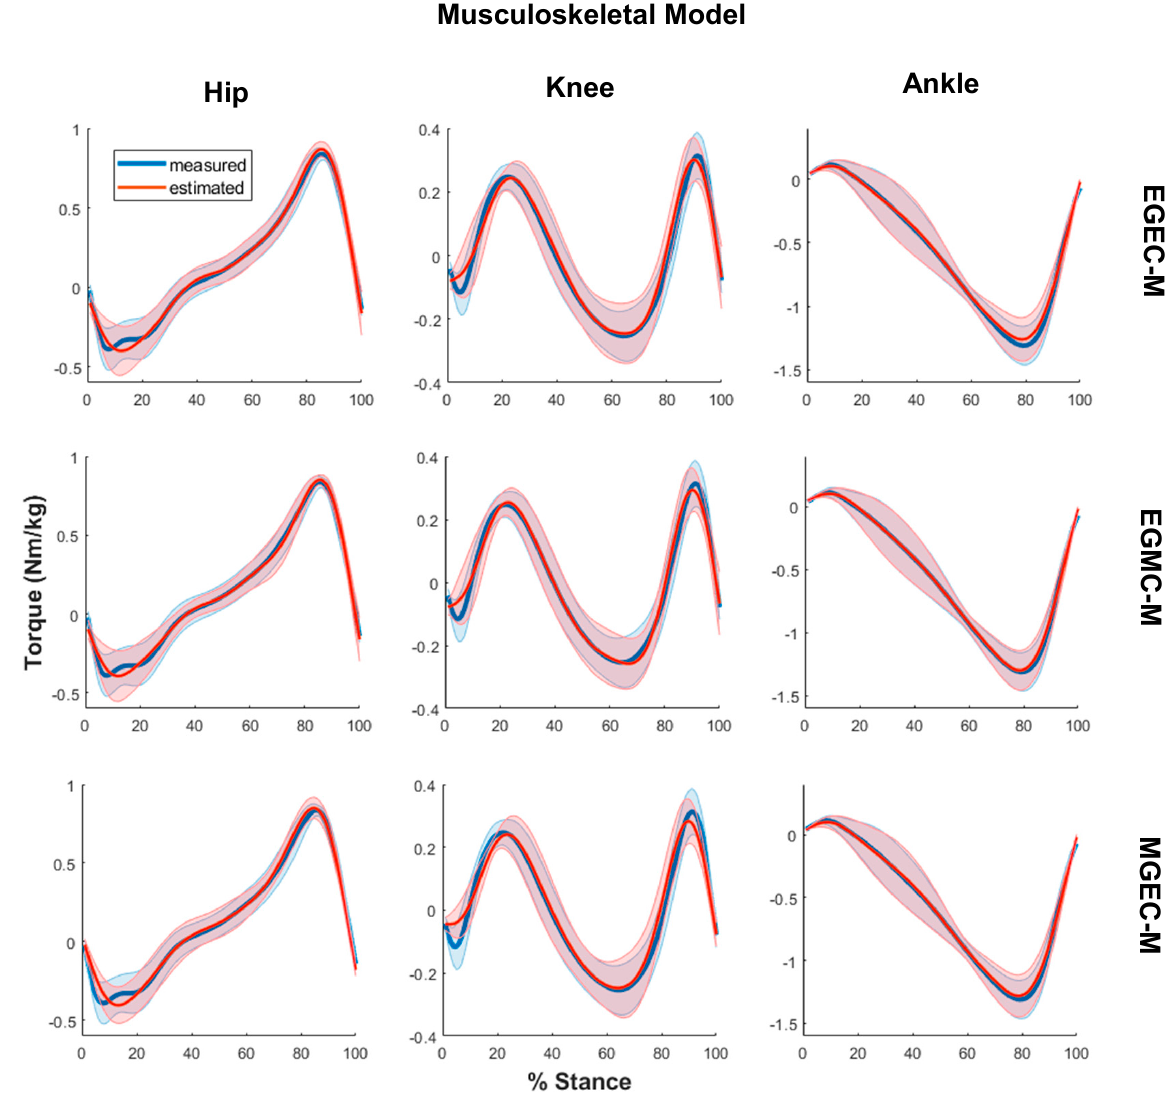
Figure 4. Measured (blue) and estimated (red) joint torques via musculoskeletal modelling for hip ( left column ), knee